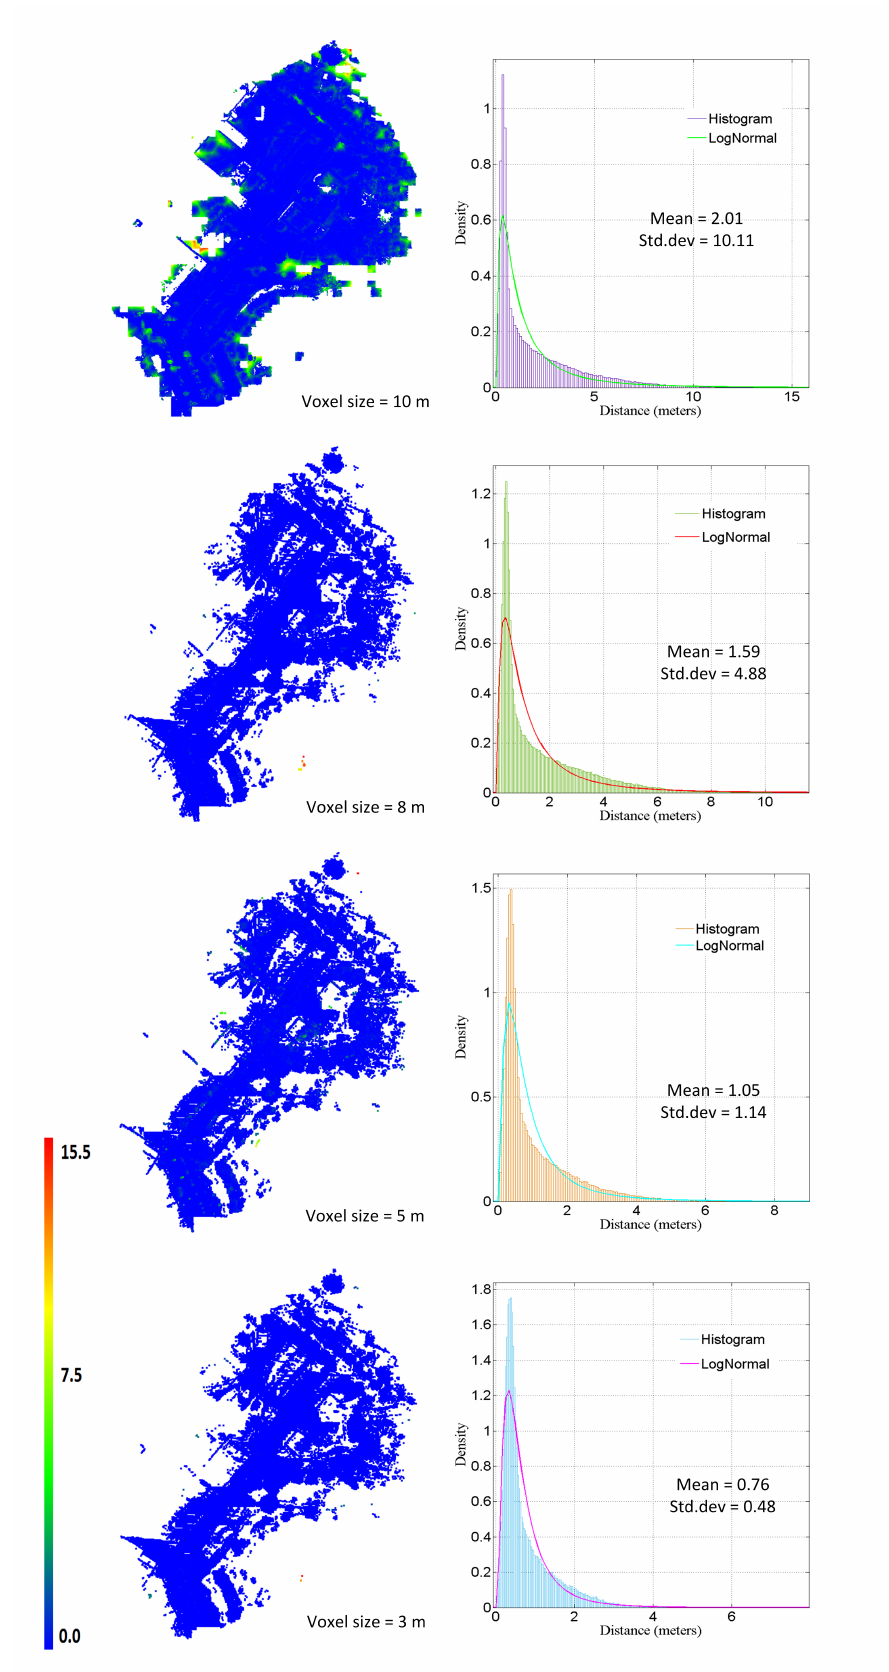
Figure 7: Cloud to cloud distances and statistical analysis from four different voxel cell